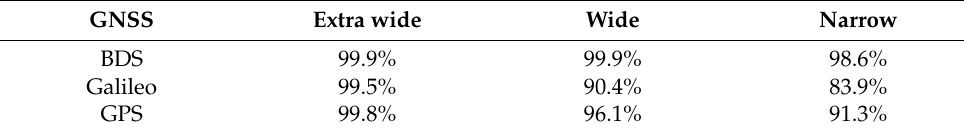
Table 5. Statistics of ambiguity resolution performance.